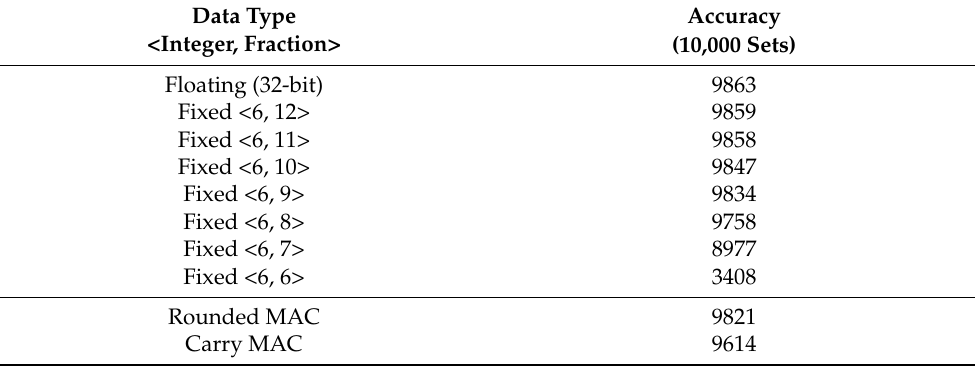
Table 2. Comparison of classification accuracies between accelerator